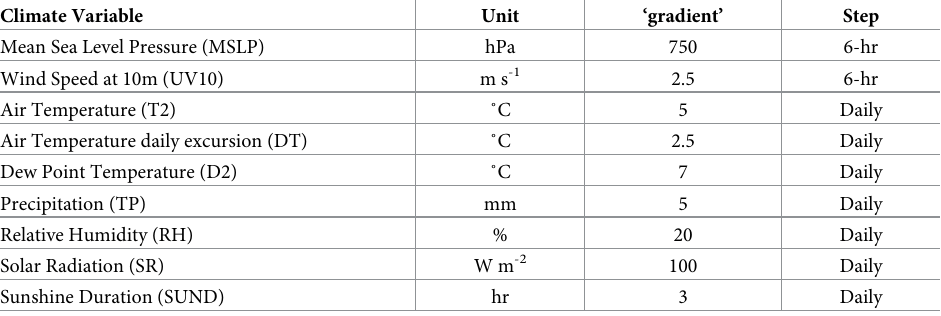
Table 1. Meteorological variables used in this study, as derived from the ERA-Interim reanalysis. The following statistics have been computed for all variables: Mean, 1 st Quartile (bottom Q), Median, 3 rd Quartile (top Q), Standard Deviation of the original time series (SD), Standard Deviation of monthly means (SD S, representing intra-annual vari- ations) and temporal variations (representing short-term ‘gradients’). The latter are computed according to daily or 6-hourly steps (see column Step). For 6-hourly variables, increments are increased by 10% at each subsequent steps (out to 5 steps, i.e. 30 hours) and by 15% for daily steps (out to 5 days). For air temperature (at 2 m height), also daily excursions are calculated using two additional variables, T min and T max , available at 6-hour intervals. Climate Variable Unit ‘gradient’ Step Mean Sea Level Pressure (MSLP) hPa 750 6-hr Wind Speed at 10m (UV10) m s -1 2.5 6-hr Air Temperature (T2) ˚C 5 Daily Air Temperature daily excursion (DT) ˚C 2.5 Daily Dew Point Temperature (D2) ˚C 7 Daily Precipitation (TP) mm 5 Daily Relative Humidity (RH) % 20 Daily Solar Radiation (SR) W m -2 100 Daily Sunshine Duration (SUND) hr 3